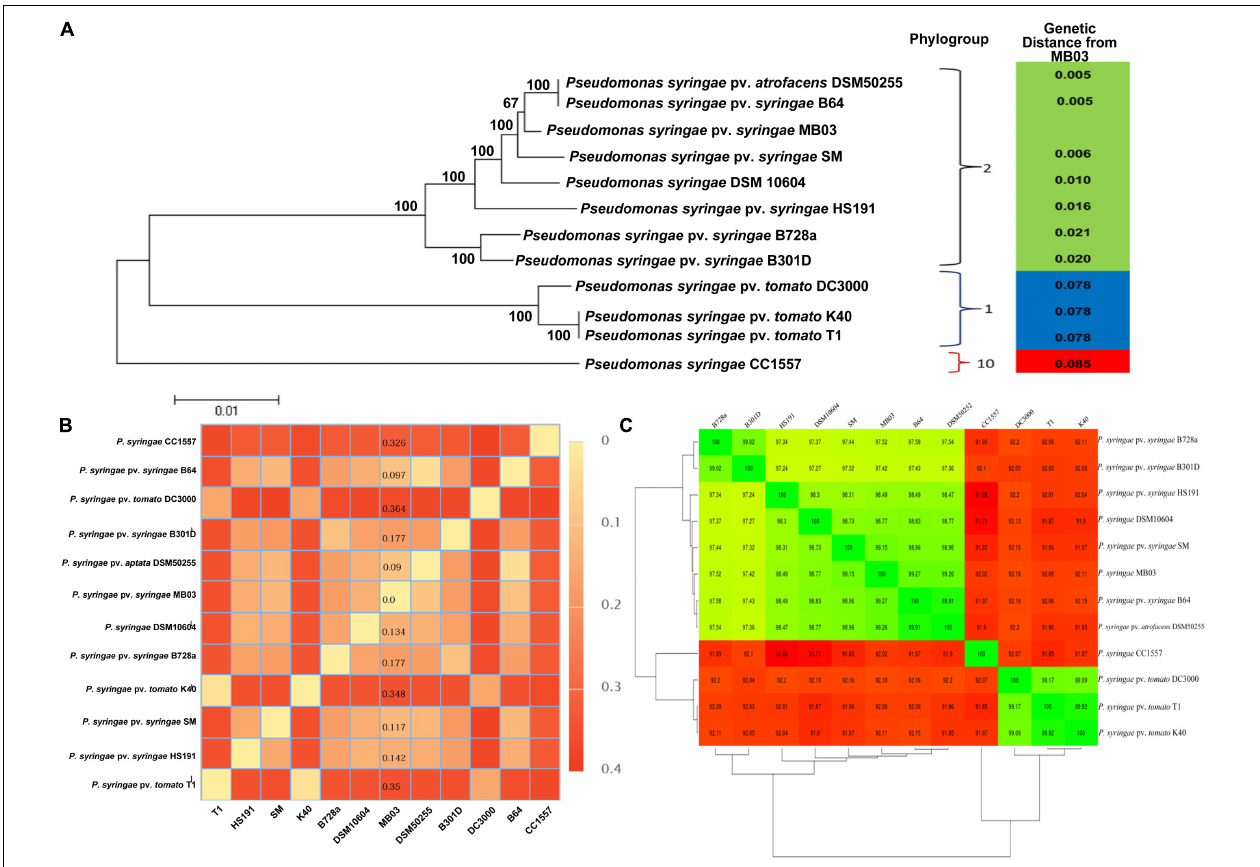
FIGURE 2 | Phylogenetics of P. syringae MB03. Phylogenetic analysis of P. syringae MB03 was performed based on MLSA using seven housekeeping genes (A) . The tree was constructed by the neighbor-joining method by MEGA5 and bootstrap values are shown at internal nodes. Based on seven genes, the genetic distance of MB03 from other strains was determined, shown in the right panel. Strain MB03 was grouped in phylogroup II of P. syringae species. Genome-to-genome distance of strain MB03 with other strains is also shown (B) . Least distance of P. syringae MB03 was observed with P. syringae DSM50255, B64 and SM. The mean amino acid identity matrix is shown for selected strains (C) . The numerical value within a box shows the percent of the mean amino acid identity of homologs of two strains. Red and green colors are used to show percent similarity.